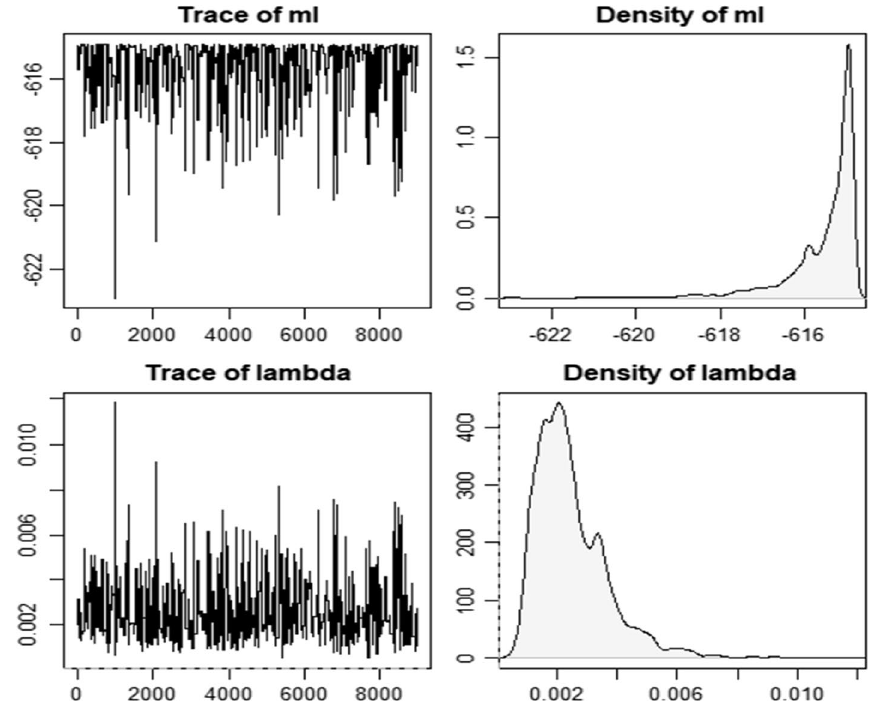
Fig. 2 Trace of hyper-parameter γ and corresponding marginal